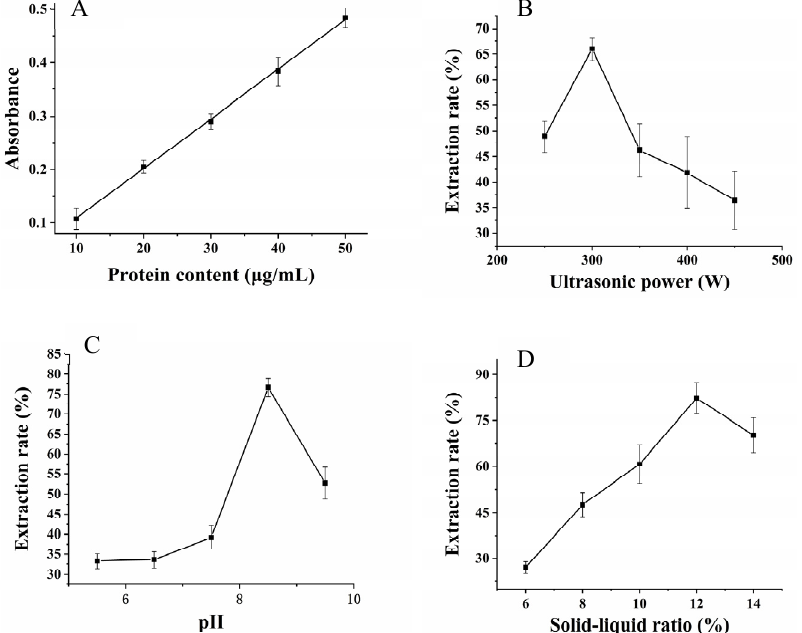
Figure 1. The standard curve of protein ( A ) and single factor experiments for power of ultrasound ( B ), pH of extraction ( C ) and solid-liquid ratio ( D ).